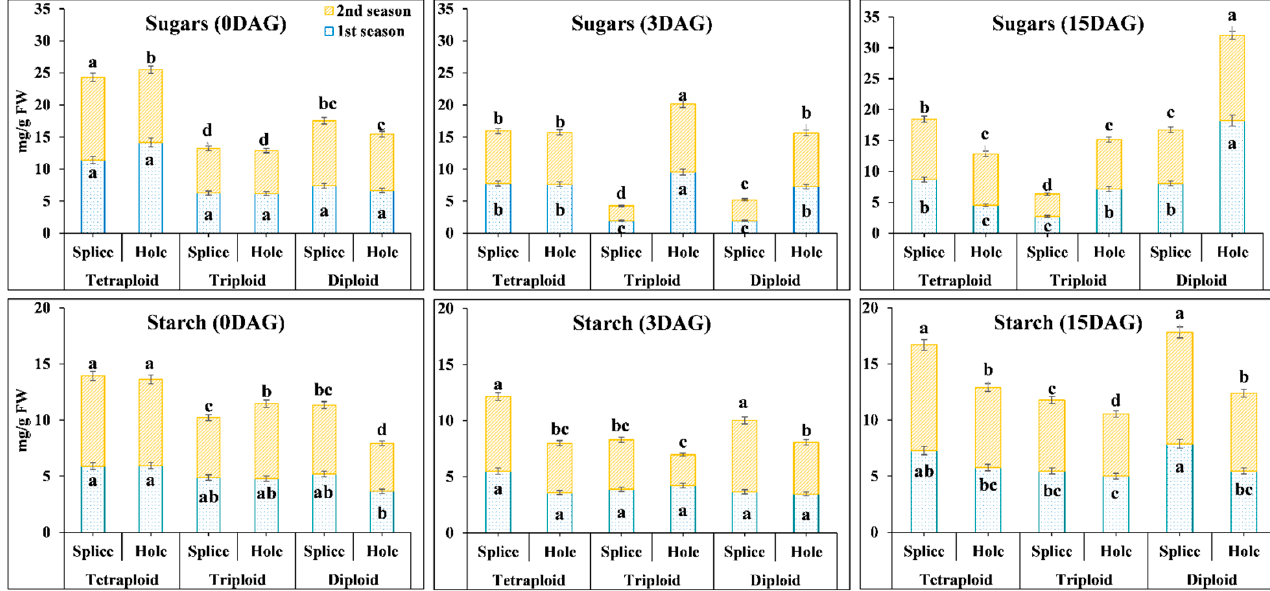
Figure 5. Sugars and Starch contents at different ploidy watermelon grafted with splice and hole methods at 0, 3, and 15 DAG. The bars with different letters differ significantly ( p < 0.05). DAG: Days after grafting.